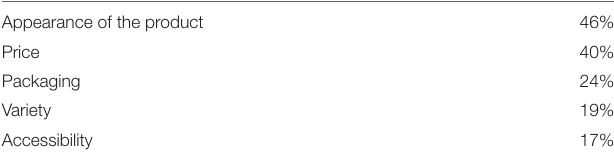
TABLE 8 | Marketing attributes for consumers buy the